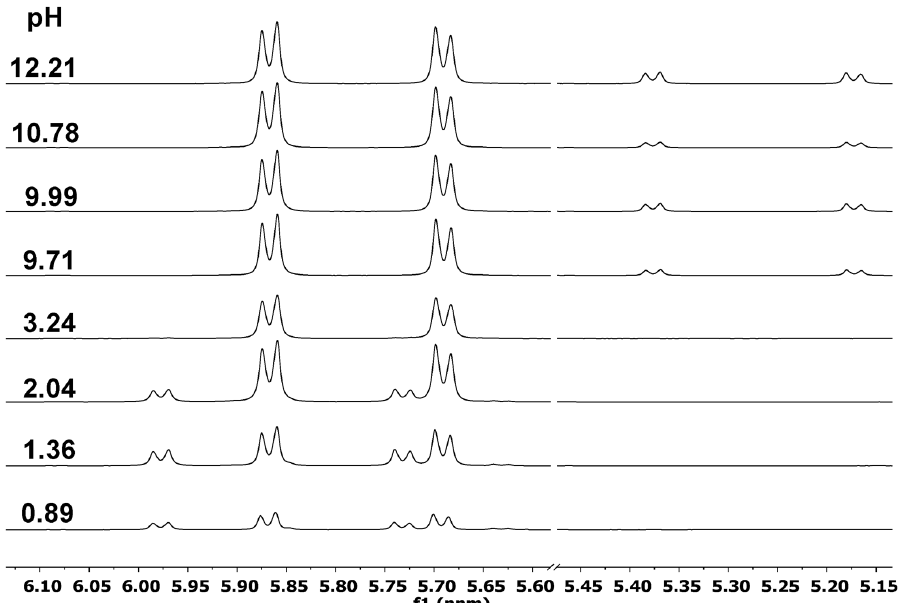
Figure 5. The pH-dependence of the 1 H NMR signals belonging to the neighboring ring protons of [( η 6 - p -cym)Ru] 2+ moiety registered with Ida 2 − at a 1:1 ratio (c Ru = 10 mM, I = 0.20 M KNO 3 ). At pH 0.89, in addition to the signals (5.73 and 5.98 ppm) of the free [( η 6 - p -cym)Ru] 2+ , a new pair of doublets (5.69 and 5.87 ppm) belonging to the complexed metal ion can be seen (Figure 5). Up to pH 3.2, the resonances of the complex—based on pH-potentiometry this is [ML]—are present only, and they remain the major signals in the whole measured pH range.